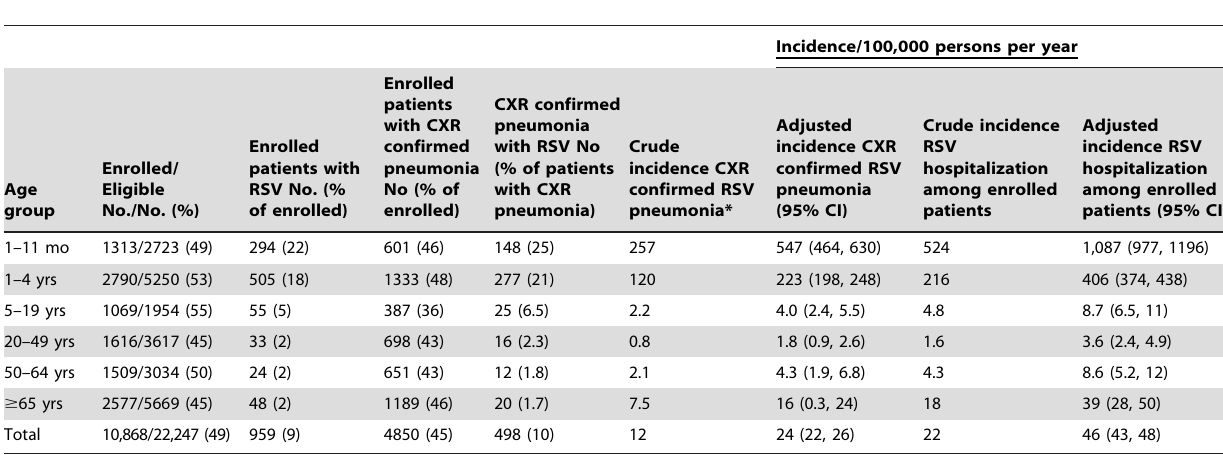
Table 1. Average crude and adjusted incidence for hospitalized patients with RSV infections, Sa Kaeo and Nakhon Phanom Provinces, January 1, 2004 – December 31,